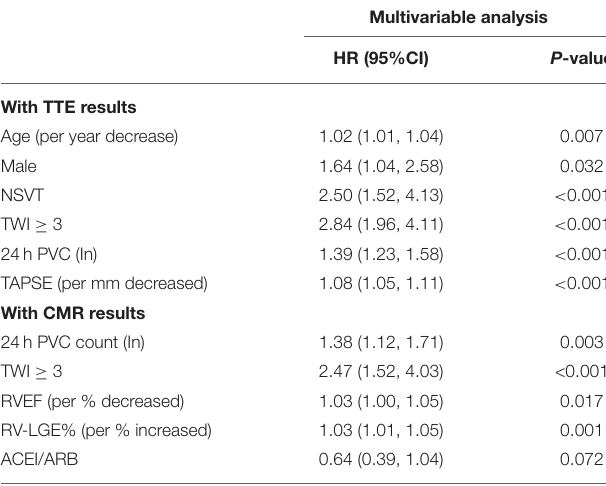
TABLE 2 | Variables associated with life-threatening ventricular arrhythmia events.